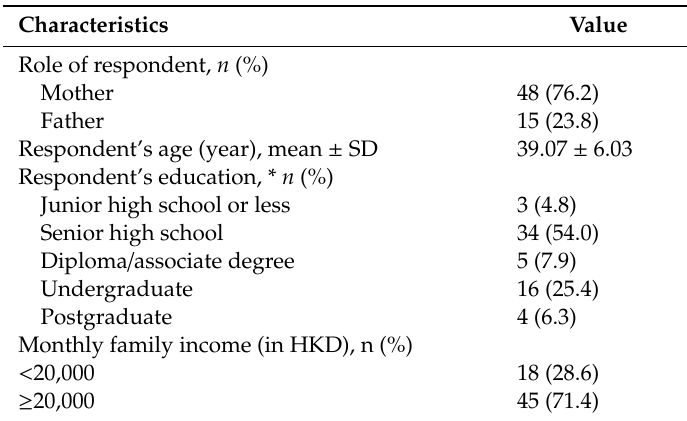
Table 2. Characteristics of the